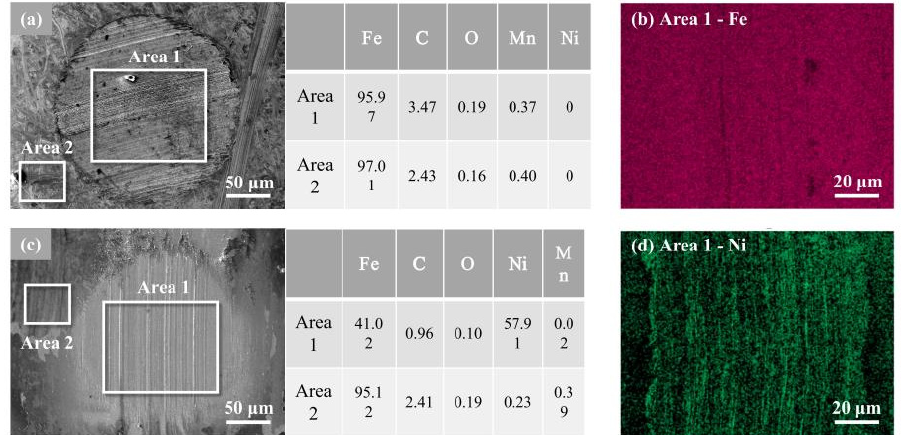
10 of 14 Figure 7. SEM morphologies of wear scars lubricated by ( a – c ) pure lithium grease and ( d – f ) 0.2 wt% Ni-doped lithium grease after four-ball tribology tests. 3.6. EDS Analysis on the Worn Surface The distribution of elements was scrutinized in the EDS mapping image of the sur- face after four-ball friction (Figure 8), which was carried out on the worn area (area 1) and non-worn area (area 2). Figure 8a,b shows a small distinction in the element content be- tween area 1 and area 2 with the pure lithium grease lubrication, which was mainly com- posed of the metal base element Fe. The high content of the C element due to the strong wear was also detected (area 1). Figure 8c,d shows the mapping image of the surface with the Ni-doped grease lubrication. The main distinction between the worn area (area 1) and non-worn area (area 2) derives from Fe and Ni elements. In the worn area, it is evident that the concave part of the wear mark is covered evenly with Ni element, which comes from the nanometer Ni in the doped grease. According to the element types found in worn surfaces, it could be inferred that the nanometer Ni can effectively penetrate the friction